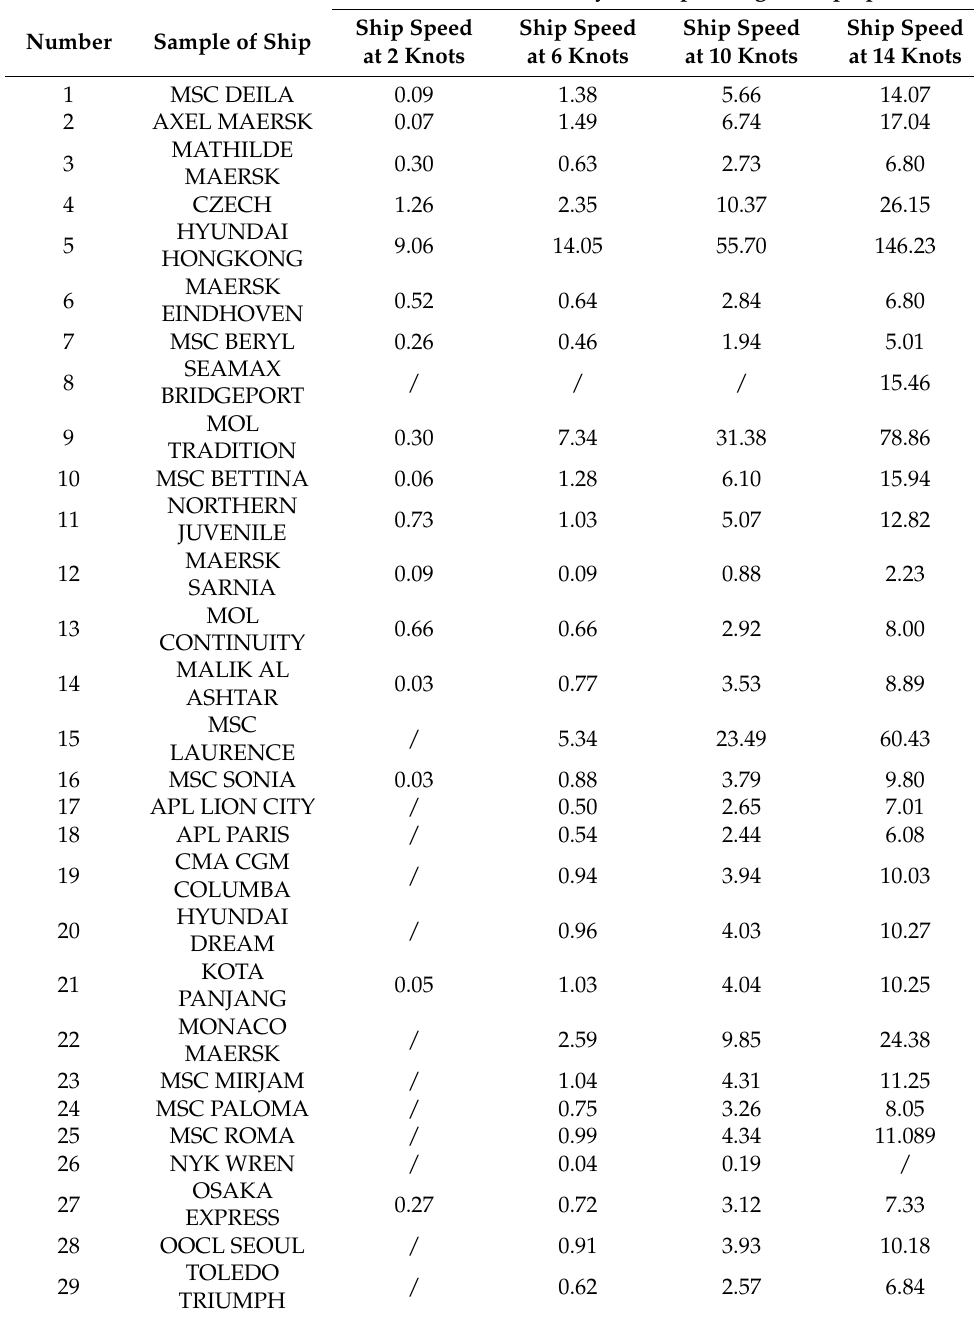
Table A2. Flus gas exit velocity corresponding to ship speed of the port of the ship sample in Dapeng Bay, Shenzhen in June